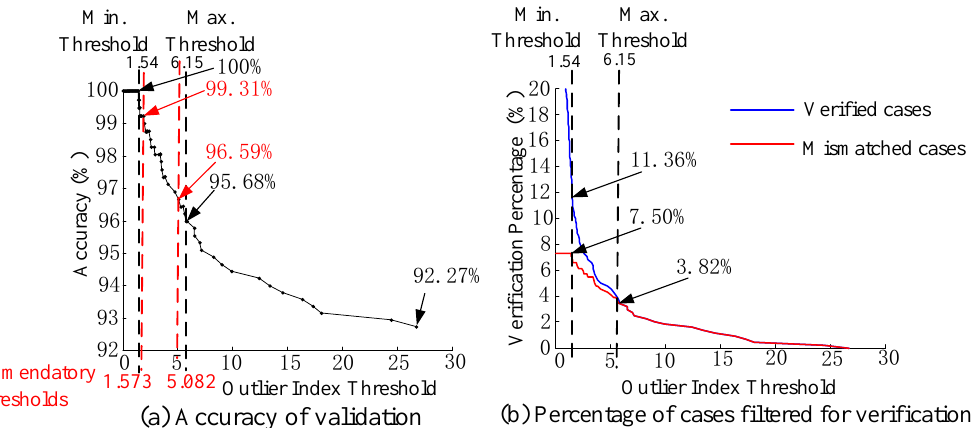
Figure 11. Accuracy and verification percentage w.r.t. different Outlier Index thresholds.